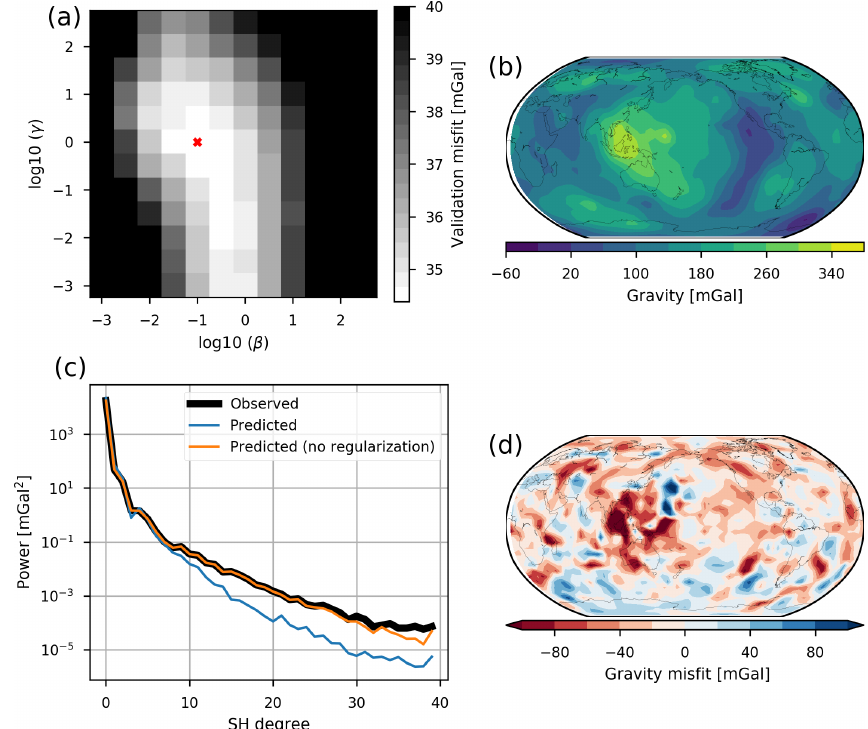
Figure 6. Results of the inversion using the crustal residual. (a) Validation misfit as a function of regularization parameter β . (b) Predicted field of the inversion results. (c) Spectral comparison of the input and predicted data. (d) Difference between input and predicted data.